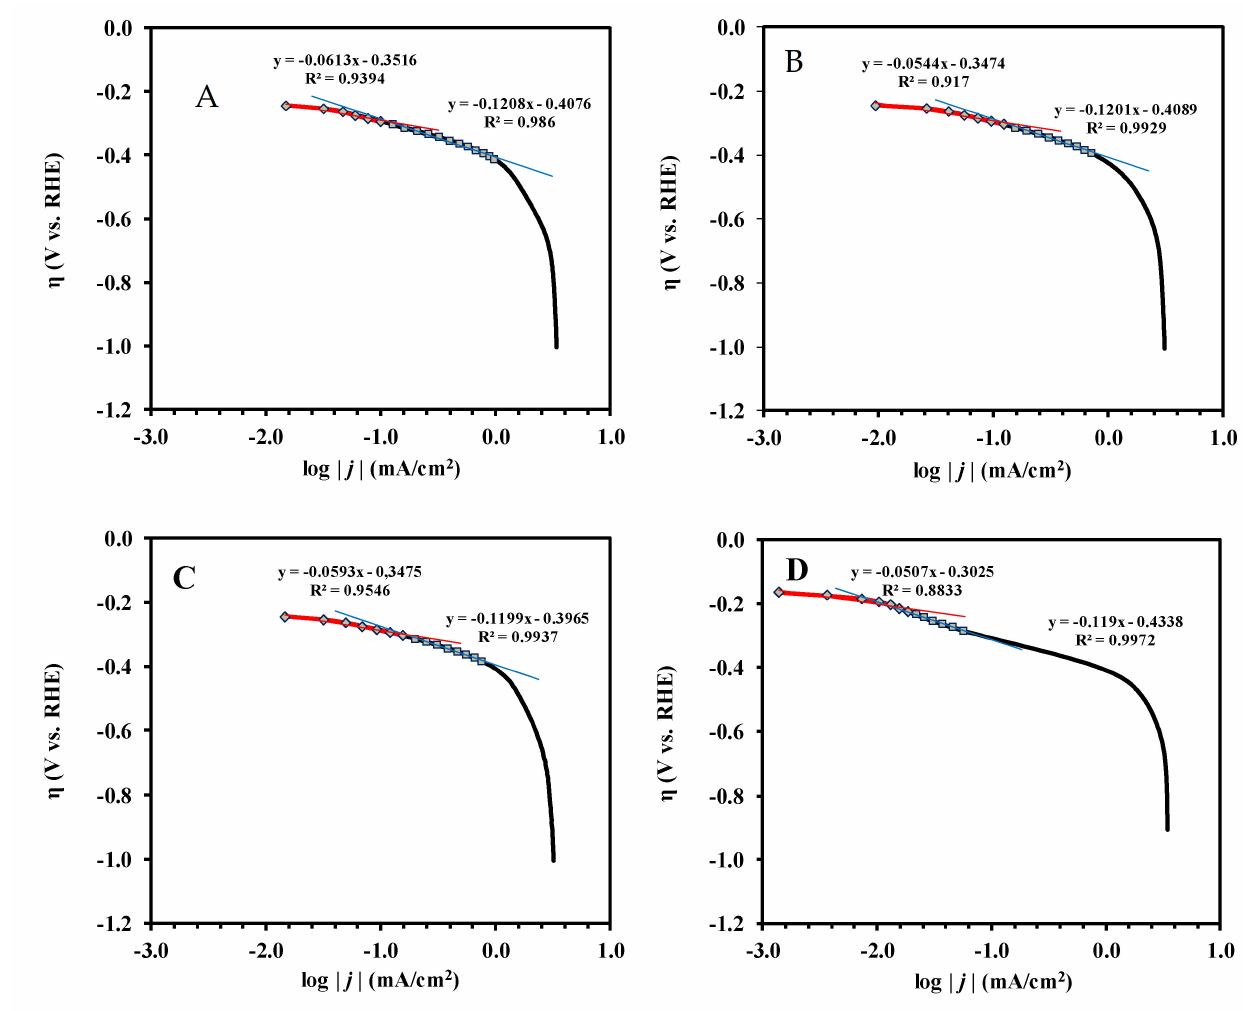
Figure 8. The Tafel plots for ORR measurements performed in 0.5 M H 2 SO 4 at ω = 900 rpm on ( A ) Pt/75BP, ( B ) Pt/75F-BP, ( C ) Pt/75V, and ( D ) Pt/C electrocatalysts presented in Figure 6A; the straight lines correspond to different Tafel